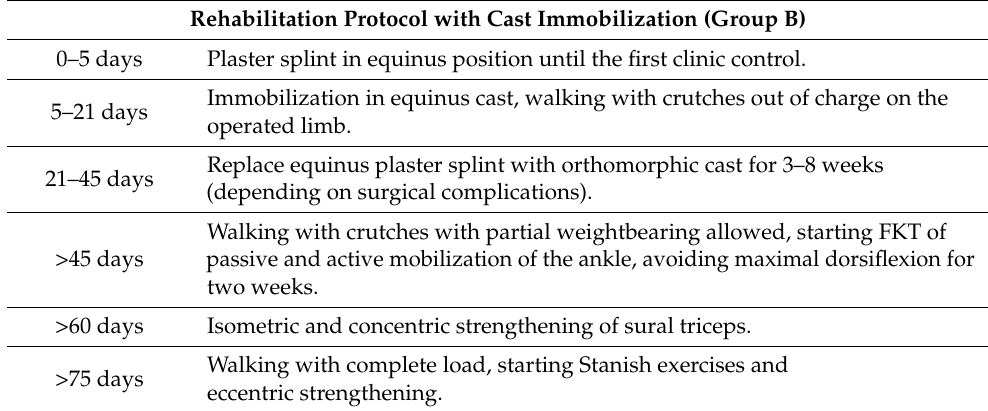
Table 3. Rehabilitation protocol with cast immobilization applied to group B. Rehabilitation Protocol with Cast Immobilization (Group